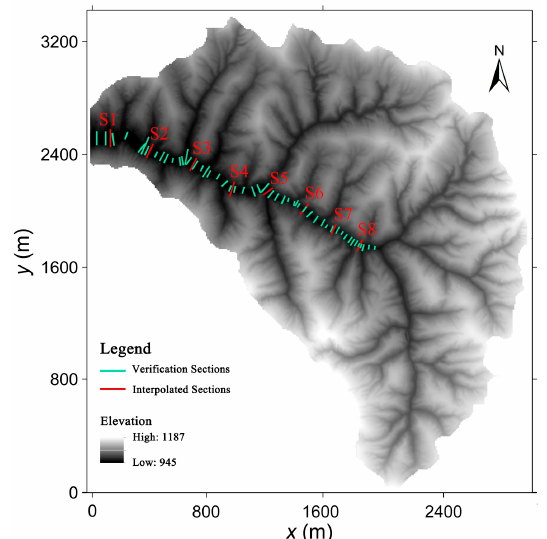
Figure 14. DEM (Digital Elevation Model) and available cross sections for Wangmaogou catchment. Unit: m.